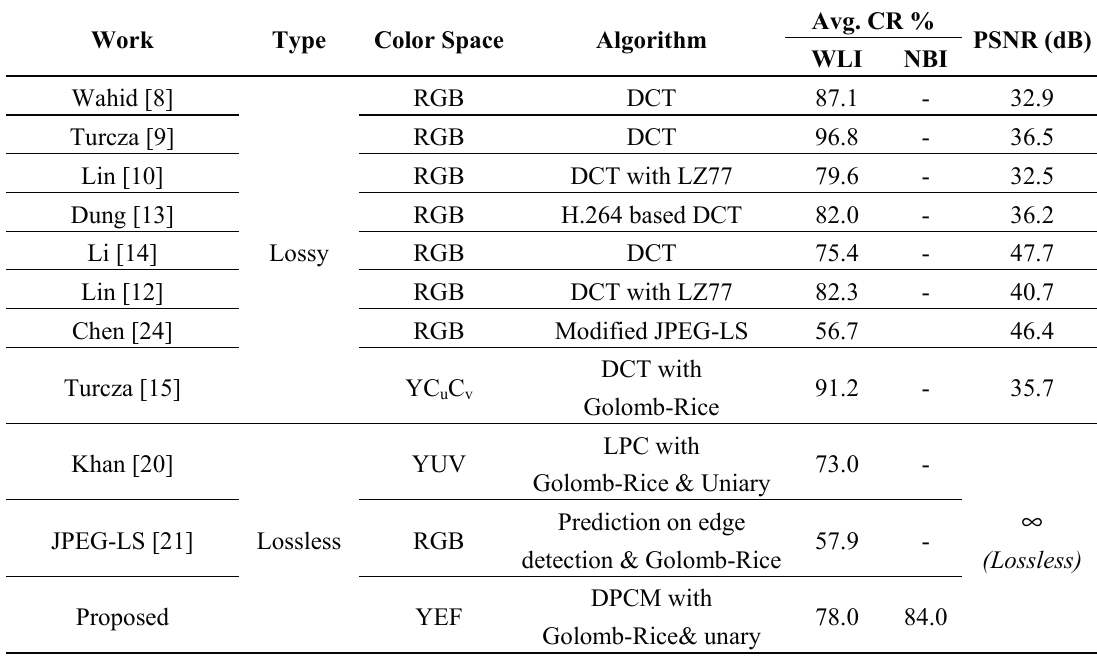
Table 7. Compression with other compression